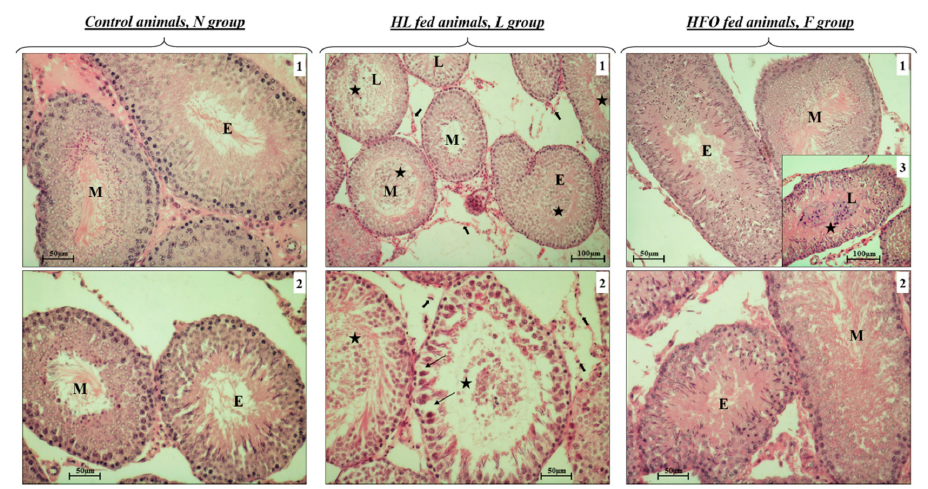
Figure 2. Morphological analysis. Morphological alterations of seminiferous tubules were evaluated using H&E stain of tissular sections. Control animals showed a normal cellular organization in the seminiferous epithelium, with a correct cellular distribution, maturation, and di ff erentiation during sperm production (N group, panels 1 and 2). The e ff ects of both HL and HFO diets showed major alterations in HL-treated animals (L group): Large space in the seminiferous epithelium (panel 2, thin black arrows) where germinal cells were found detached from Sertoli cells; nondi ff erentiated cells in the lumen in L group (L group, panels 1 and 2, black stars); a certain degree of Leydig cells atrophy was noted (L group, panel 1 and 2, big black arrows). HFO-treated animals (F group) did not present severe morphological alterations compared to N: Nondi ff erentiated cells were only detected in tubular lumen in few tubules, (F group, panel 3, black star). Magnification used: 10 × and 20 × . Scale bars applied: 50 µ m and 100 µ m. E (early stage); M (middle stage); L (late